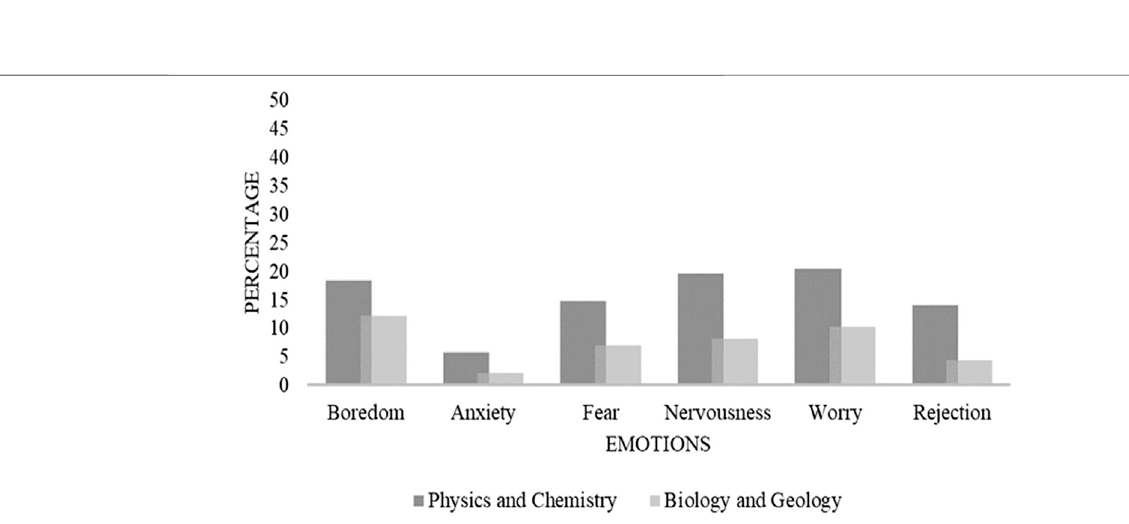
FIGURE 1 | Percentage of positive emotions toward science expressed by the prospective teachers.